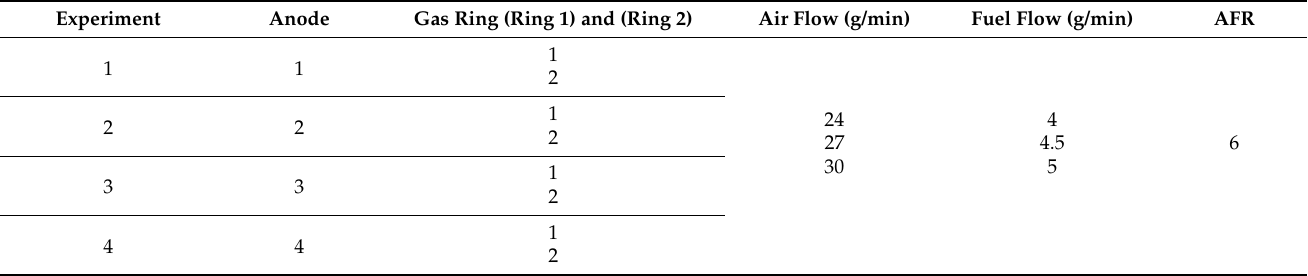
Table 1. Fuel reformer system